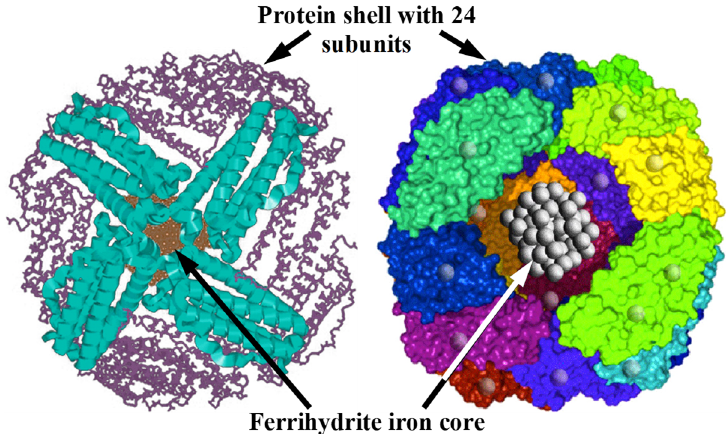
Figure 3. Two schematical views on the ferritin structure with indications of protein multi‑subunit shell and the iron